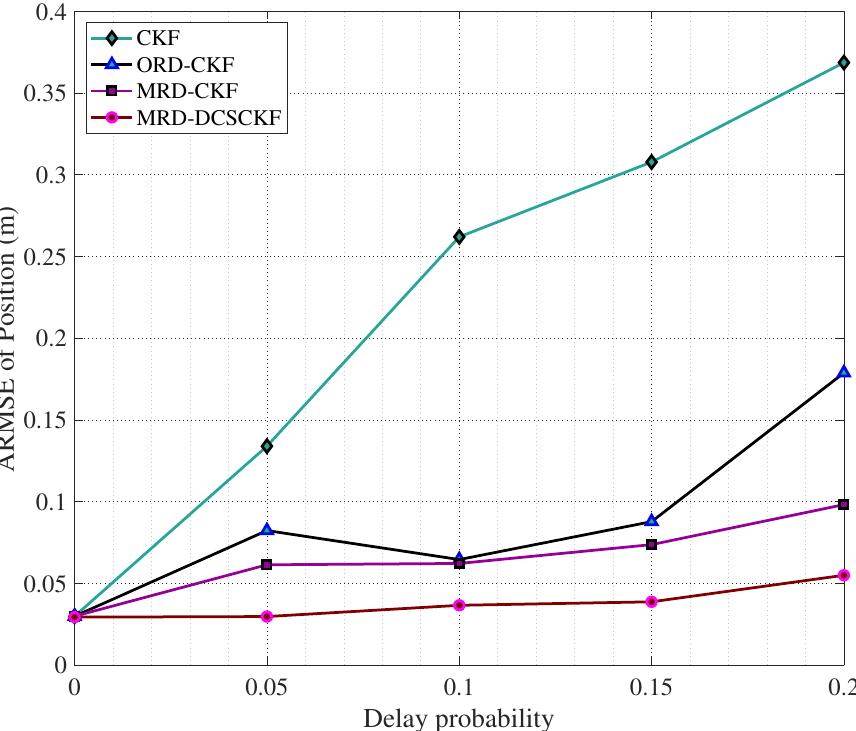
Figure 16. ARMSEs of position under different delay probabilities.